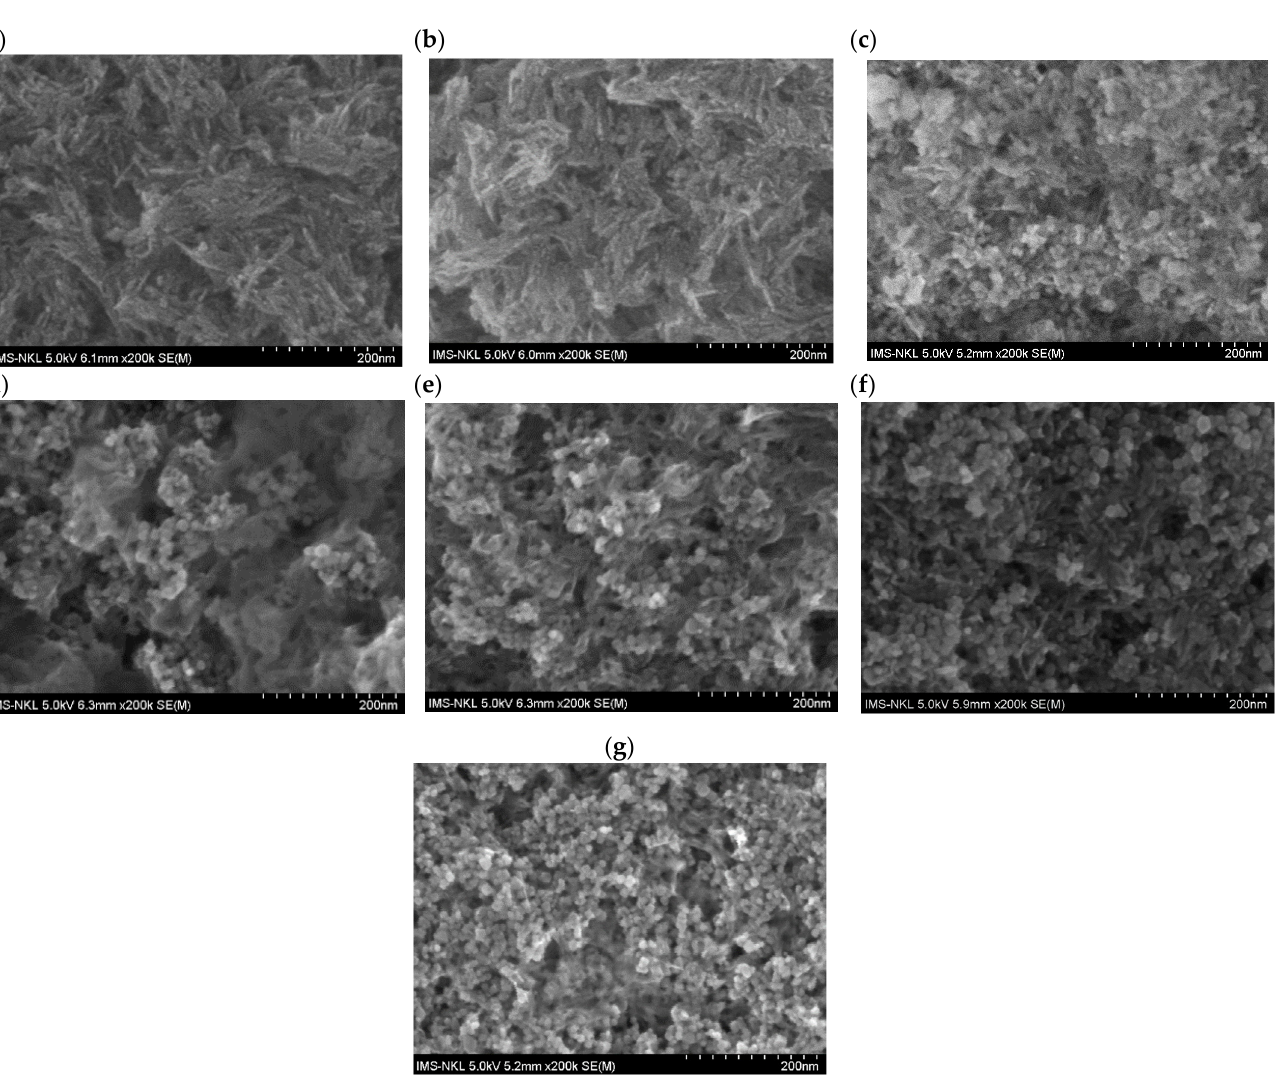
Figure 9. TEM images of a SPION/HAp nanocomposite sample containing ( a ) 80% and ( b ) 90% of SPIONs. Complementary to the SEM analysis, the EDS measurements were performed to con- firm the presence of particular elements of HAp in the composite. It can be seen from EDS analysis that Fe 3 O 4 nanoparticles give apparent Fe- and O-related peaks where no other contamination-related peaks can be seen. The EDS results of SPION/HAp nanocomposite are presented in Figure 10b,c, where the particular peaks for Ca, Fe, and O can be seen, where the content of SPIONs in the composite was 50% and 80%, respectively. ( a ) ( b ) ( c ) Figure 10. EDS spectra for the ( a ) bare SPION, ( b ) 50% SPION/HAp, and ( c ) 80% SPION/HAp.